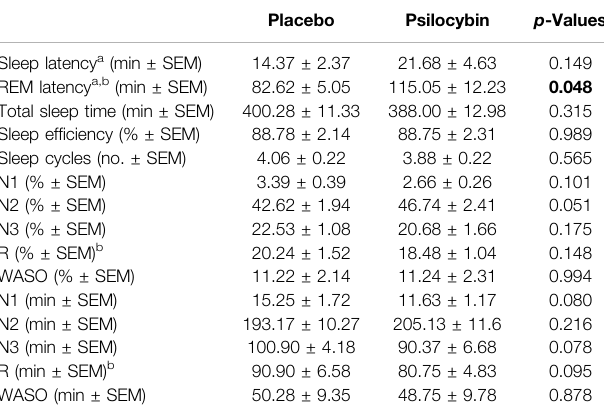
TABLE 1 | Sleep macrostructure after daytime administration psilocybin and placebo (uncorrected).